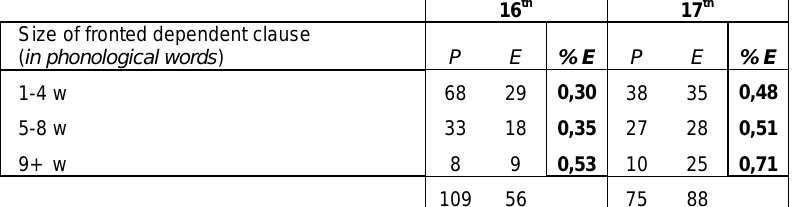
Table 2a : The effect of the length of pre-verbal dependent clauses on clitic placement in authors born in the 16 th and 17 th centuries 16 th 17 th Size of fronted dependent clause ( in phonological words ) P E % E P E %